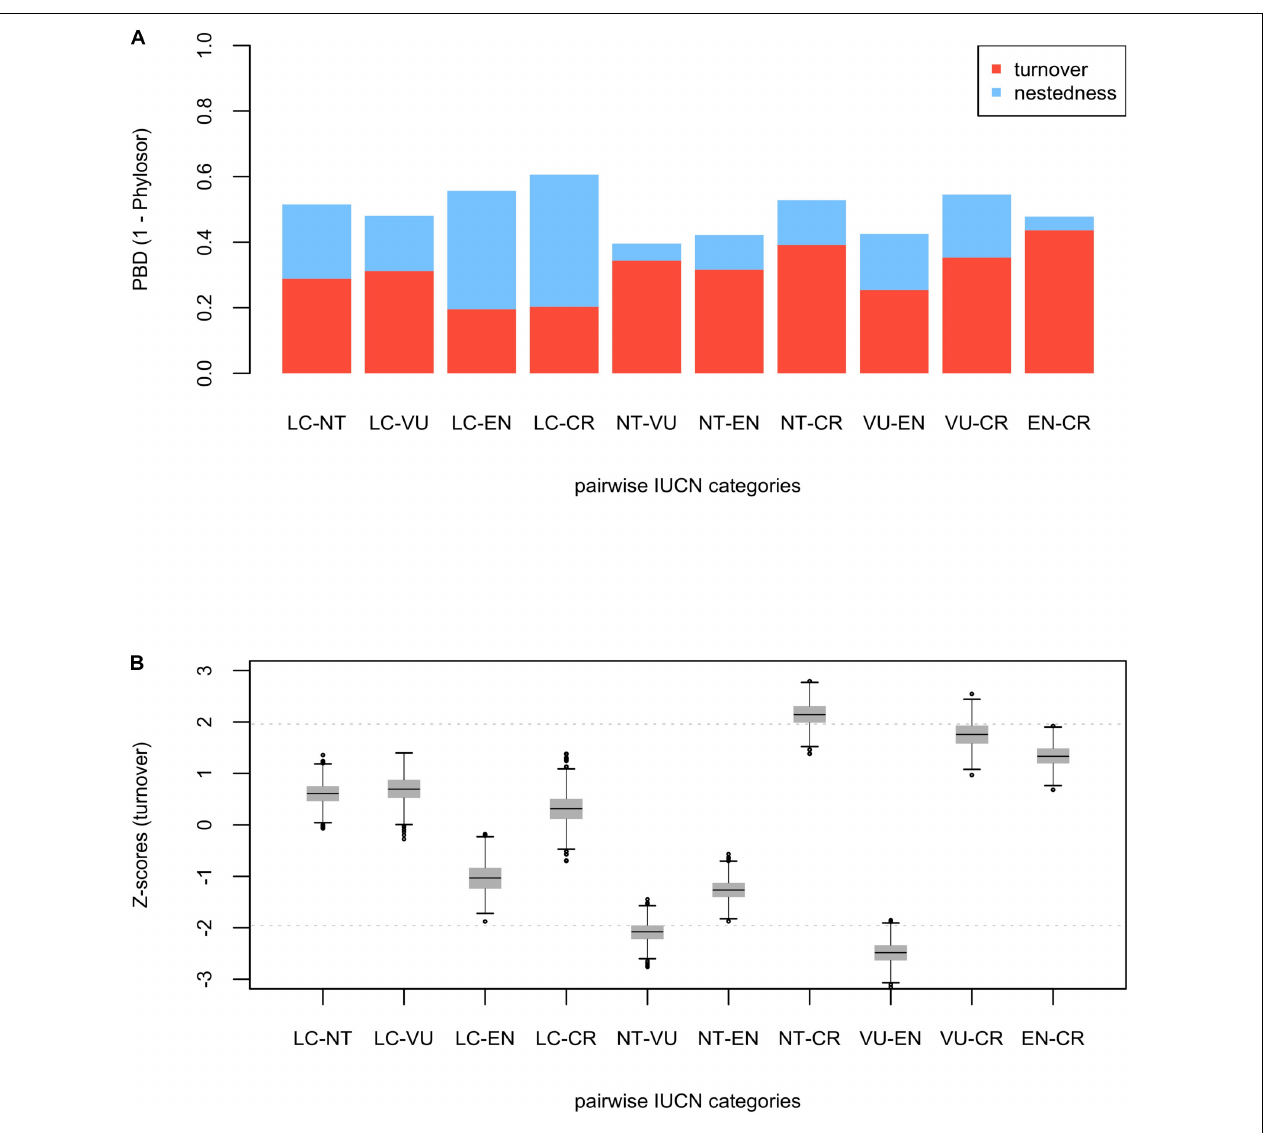
FIGURE 2 | Phylogenetic beta diversity analyses (PBD) among IUCN categories (LC, NT, VU, EN, and CR) for the endemic angiosperm flora of the Iberian Peninsula. The barplot (A) shows the fraction of PBD due to phylogenetic “true” turnover (in red) and nestedness (in blue) for each pairwise comparison. The box-and-whisker plot (B) shows standardized values (Z-scores) for the turnover component. The horizontal black lines within the boxes represent the mean value of the distribution of Z-scores in each pairwise comparison, and the horizontal gray dashed lines are visual references at y = ± 1.96 (significance thresholds for a 5% nominal alpha).